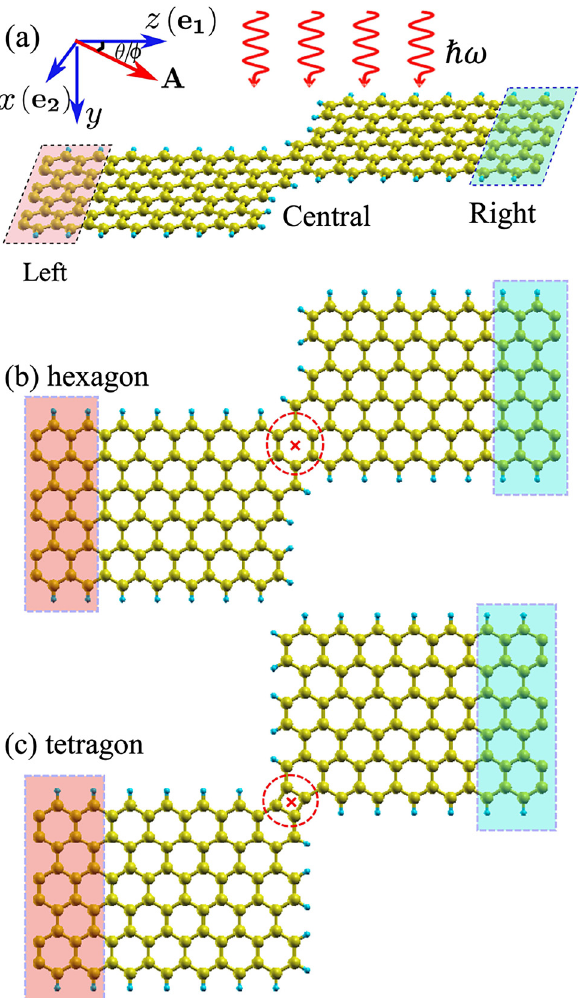
Figure 1: (a) The photovoltaic junction model constructed with two 6-ZGNRs interconnected at two corners. (b) The top view of Junction C6 with a hexagon at the connection; (c) the top view of Junction C4 with a tetragon at the connection. Light is normally incident to the xz ̂ z and e ̂ x are two polarized vectors that determine the plane. e 1 = 2 = incident direction of the polarized light. The red spiral arrows denote the applied polarized light. A is the electromagnetic vector potential and 𝜃 ∕ 𝜙 is the polarization/helicity angle of the linearly/elliptically polarized light. The red circle indicates the hexagon or tetragon at the connection. The red cross in the circle indicates the spatial inversion center of the